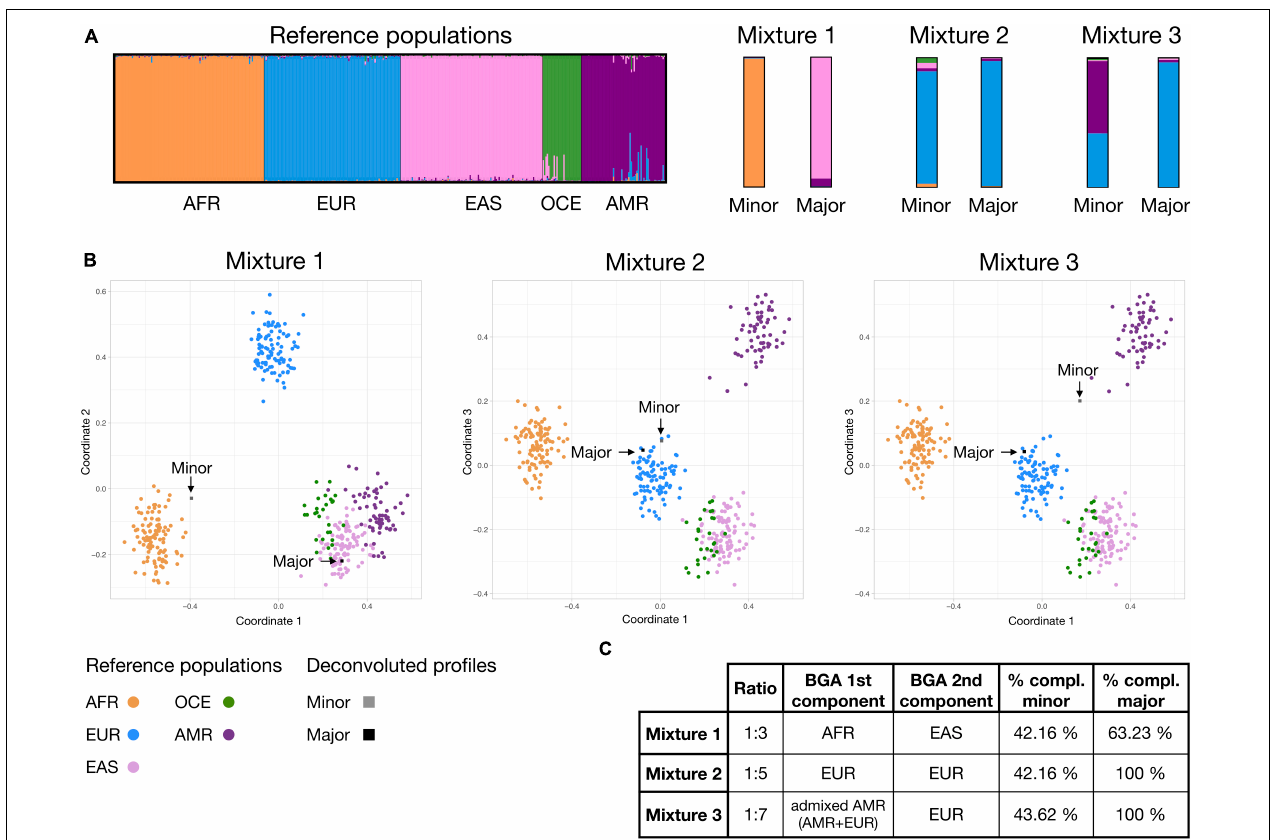
FIGURE 5 | Bio-geographical ancestry inference for the major and minor mixture components in mixtures 1, 2, and 3; classified using the continental reference set presented on Figure 3 . (A) STRUCTURE results of ancestry proportions at K = 5. Each bar represents an individual and is colored in segments whose lengths correspond to their genetic cluster membership coefficients in up to five inferred population groups. (B) Three dimensional MDS analysis showing coordinates 1 and 2 (for mixture 1) or 1 and 3 (for mixtures 2 and 3). Populations and major and minor components are colored according to the legend. (C) Table showing, for each mixture ratio, the expected ancestry of the known components and % of completeness (compl.) of the minor and major deconvoluted MH profiles. Details of the simulated profiles and deconvolution results can be found in Supplementary File S2 and Supplementary Table S8